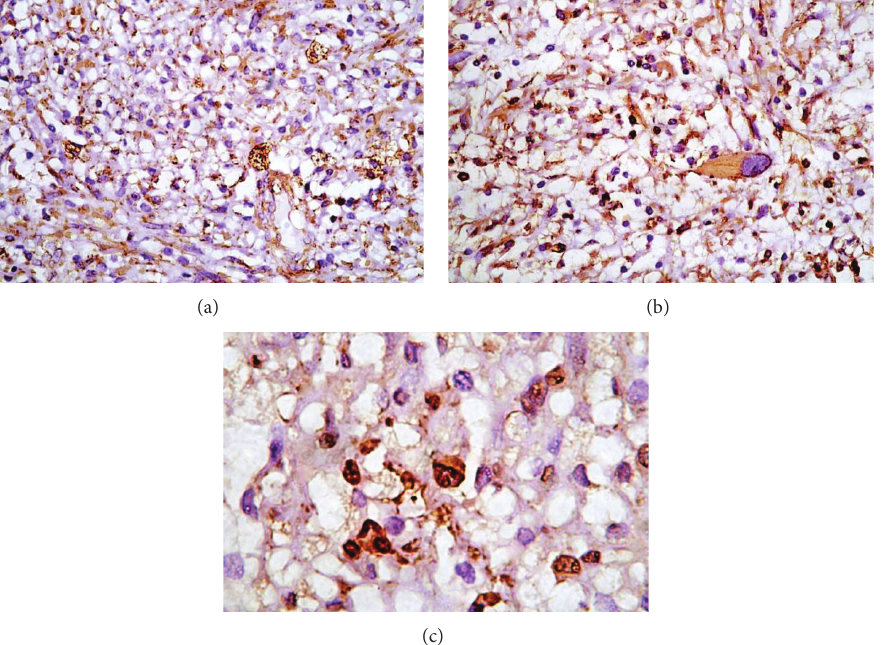
Figure 5: Immunohistochemical staining of malignant triton tumor showing the following: (a) diffuse positivity for S-100 protein ( × 200), (b) desmin positivity in the rhabdomyoblast cells ( × 200), and (c) myoglobin positivity in the rhabdomyoblast cells ( ×